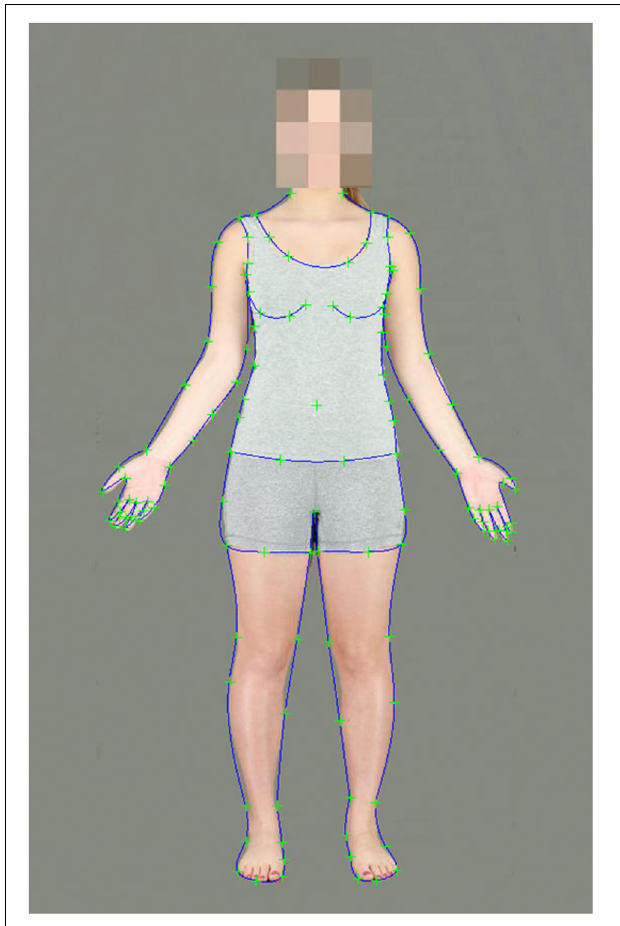
FIGURE 1 | A female body image delineated with 130 landmark